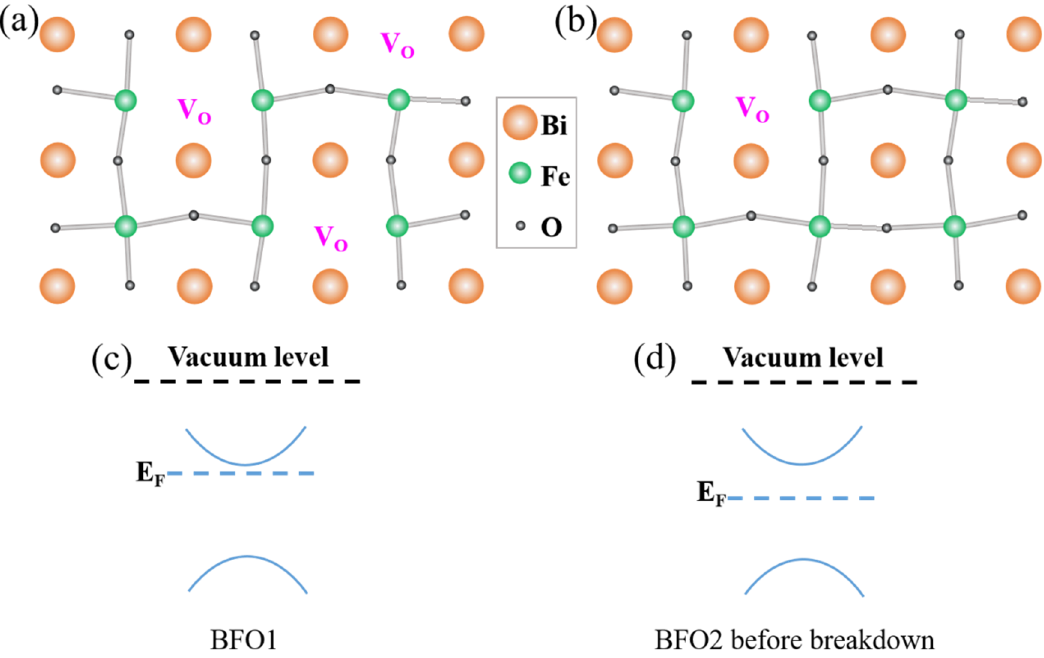
Figure 6. Crystal structure diagrams of BFO1 ( a ) and BFO2 ( b ) with different oxygen contents. The corresponding energy band diagrams of BFO1 ( c ) and BFO2 ( d ).